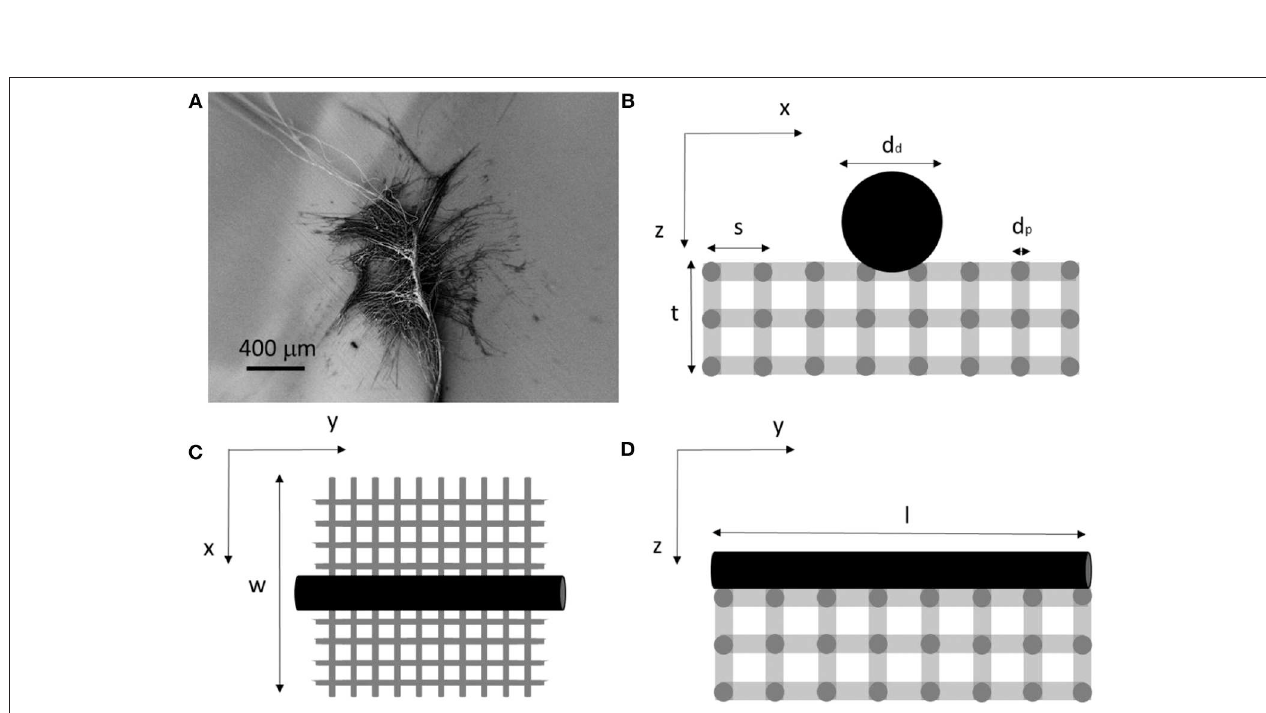
FIGURE 3 | (A) Scanning electron microscopy (SEM) picture of an attachment disc. (B–D) Schematic model in the three directions used to compute the mechanical properties of the membrane and composing fibrils.